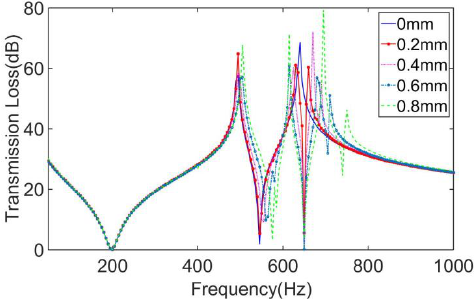
Figure 11. Comparison of the MAMs with different mass eccentricities.